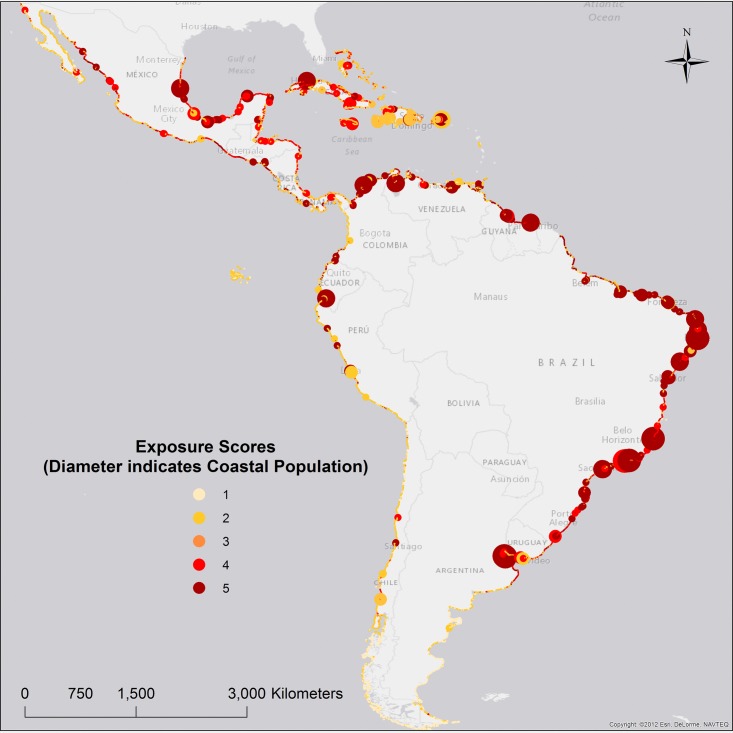
Exposure scores.